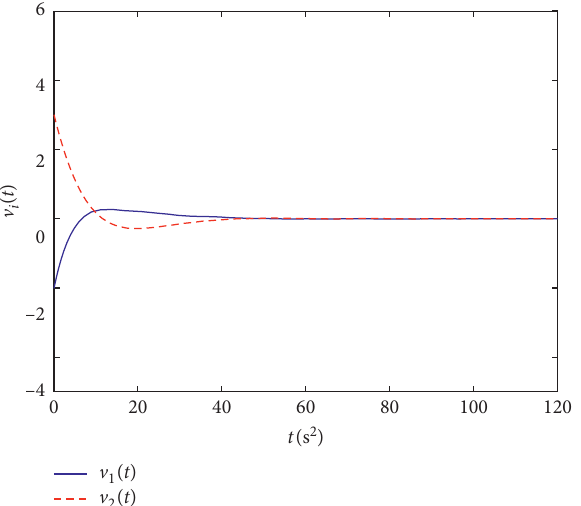
Figure 9: The velocity trajectory of each agent when τ � 0.01.